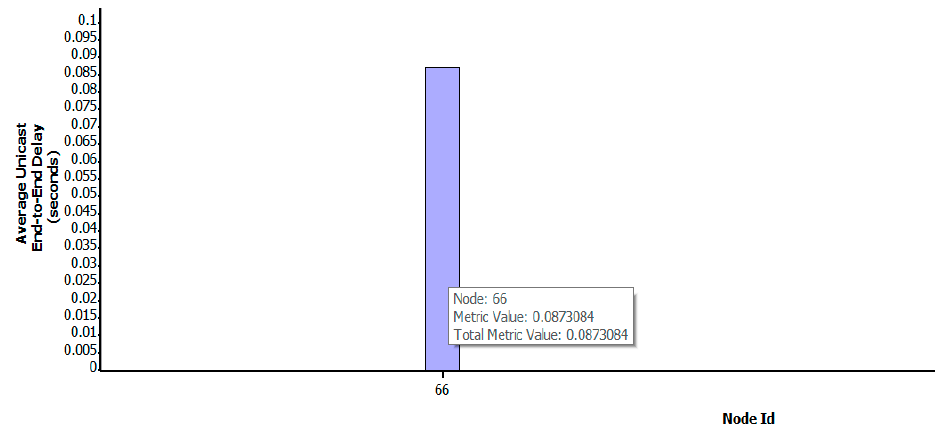
Figure 9. Five–satellite–key–node attack scenario.